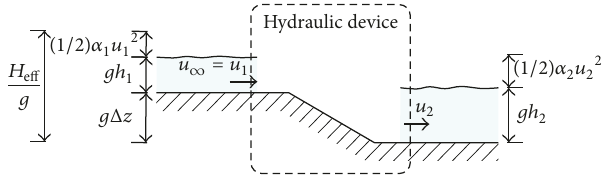
̇𝑊 usable , 𝜂 , and 𝜂 generator hydraulic load